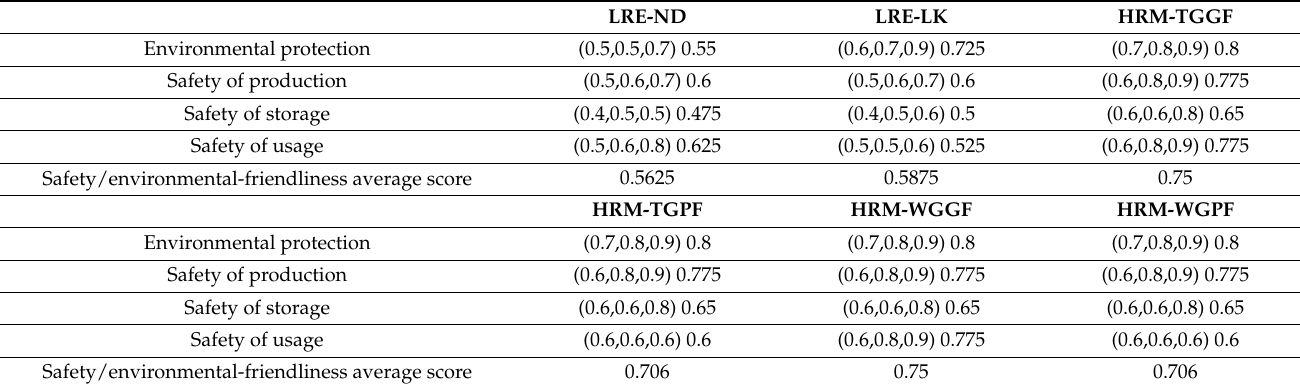
Table 5. Safety/environmental-friendliness results of expert evaluations.